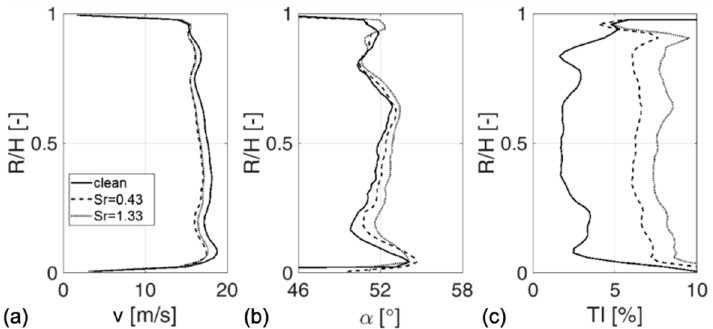
Figure 28. Time-averaged distributions of velocity v ( a ), flow angle in circumferential direction α ( b ) and turbulence intensity TI ( c ) over channel height R/H downstream of the rotating wake gen- erator for Sr = 1.33, φ = 0.97 and clean inflow, see [58].